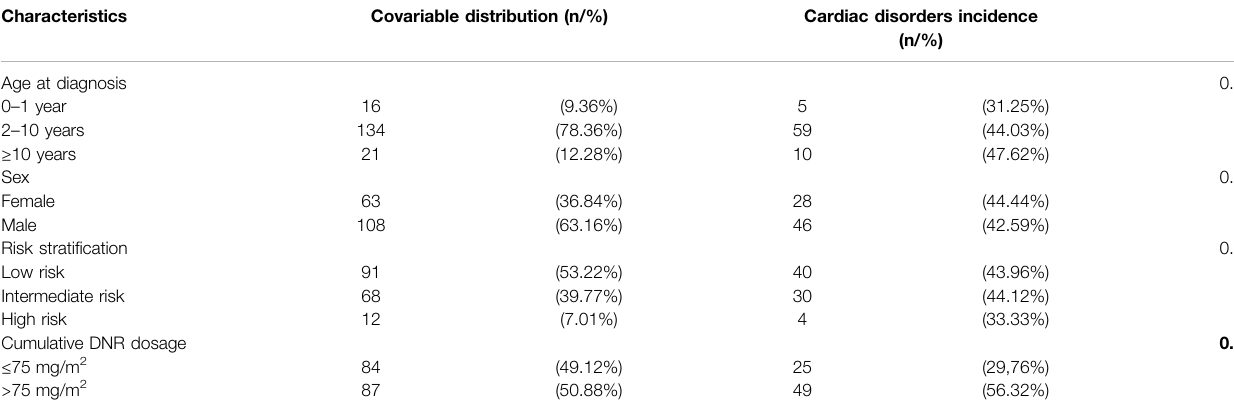
TABLE 2 | Characteristics of the ALL patients and the incidence of cardiac disorders. Characteristics